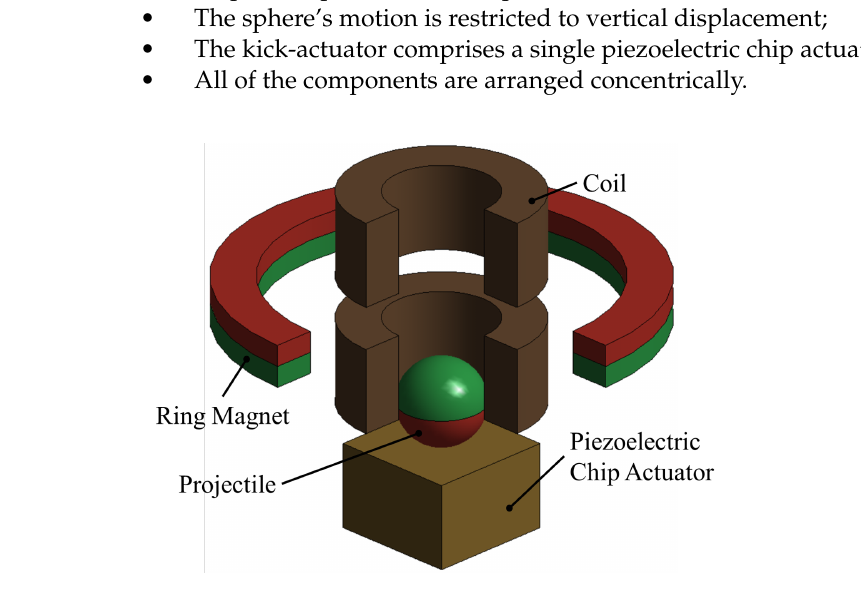
Figure 2. Sectional three-dimensional view of the simplified actuator system with labeled components. This setup deploys a piezoelectric chip actuator for kick-actuation and an assembly of two coils and a ring magnet for electromagnetic interaction. Additionally, the micromirror is included as a magnetic sphere. The setup is designed for preliminary studies. This basis will be extended by more complex assemblies to precisely manipulate the micromirror.